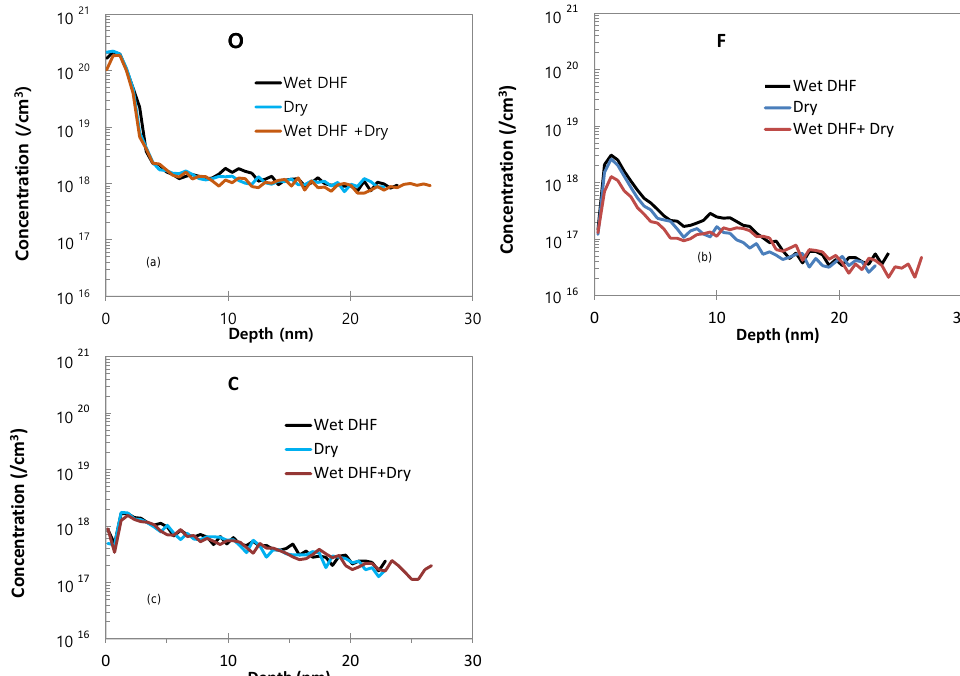
Figure 3. The SIMS profiles of the Si epitaxial films obtained after ex-situ wet pre-cleaning with 1:200 DHF, dry cleaning, and combined wet + dry cleaning, indicating the concentrations of ( a ) O, ( b ) F, and ( c ) C.